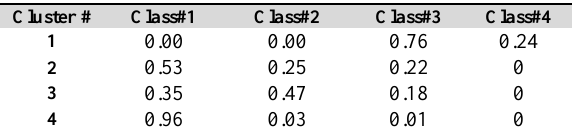
Table 3. Probability distribution of four selected clusters illustrating four individual road surface anomalies in four different rod segments